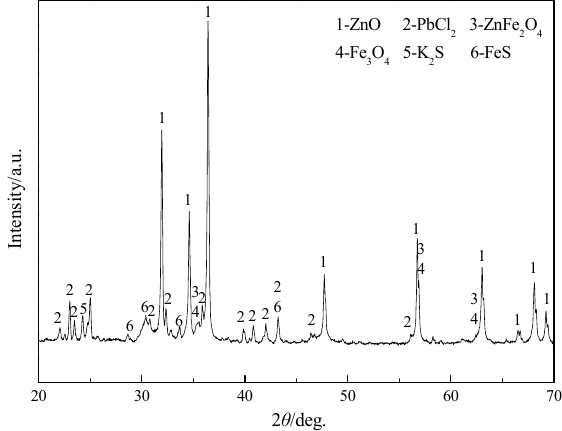
Figure 1. XRD pattern of SZO.